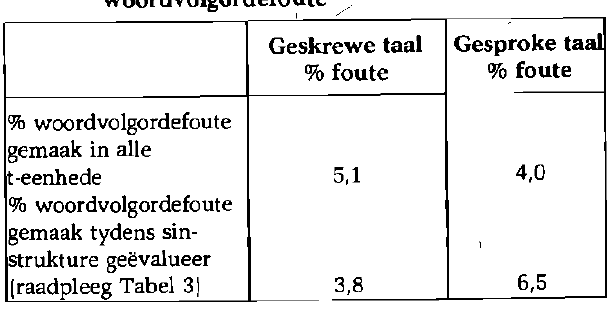
Tabel 5: Resultate ten opsigte van proefpersone